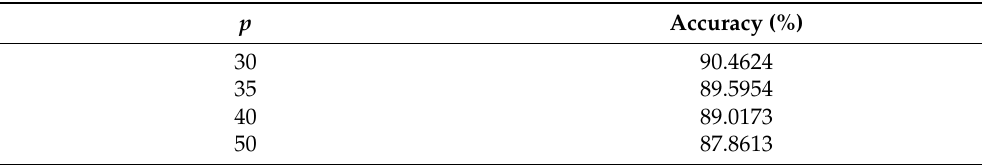
Table 4. Comparison with different adaptive thresholds on the HNUFDD dataset for fatigue driving behavior recognition.